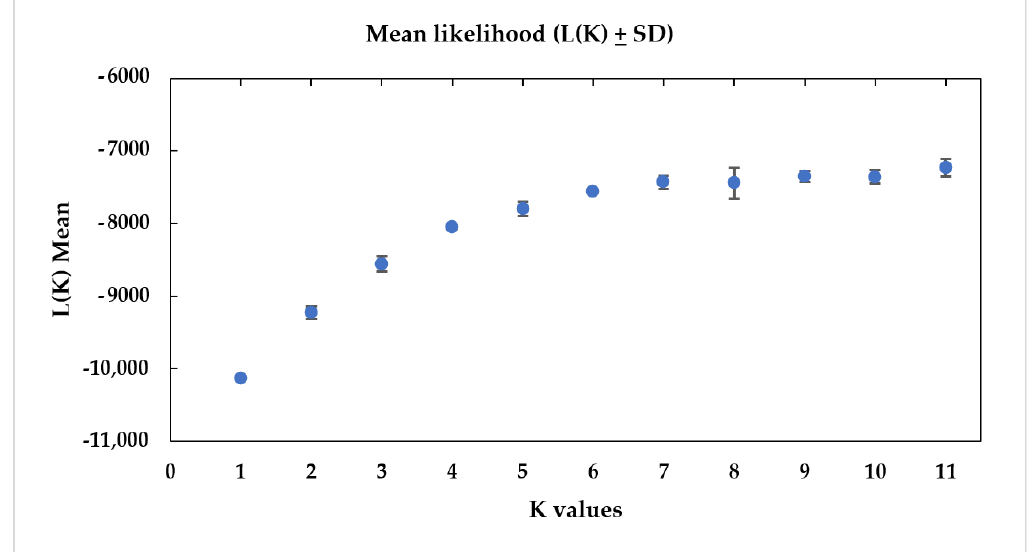
Figure 3. Plot of mean likelihood L(K) and variance per K value from STRUCTURE on 181 Tor spp. samples genotyped for 22 polymorphic microsatellite loci. Mean L(K) was obtained over 20 independent runs for 11 different K values.